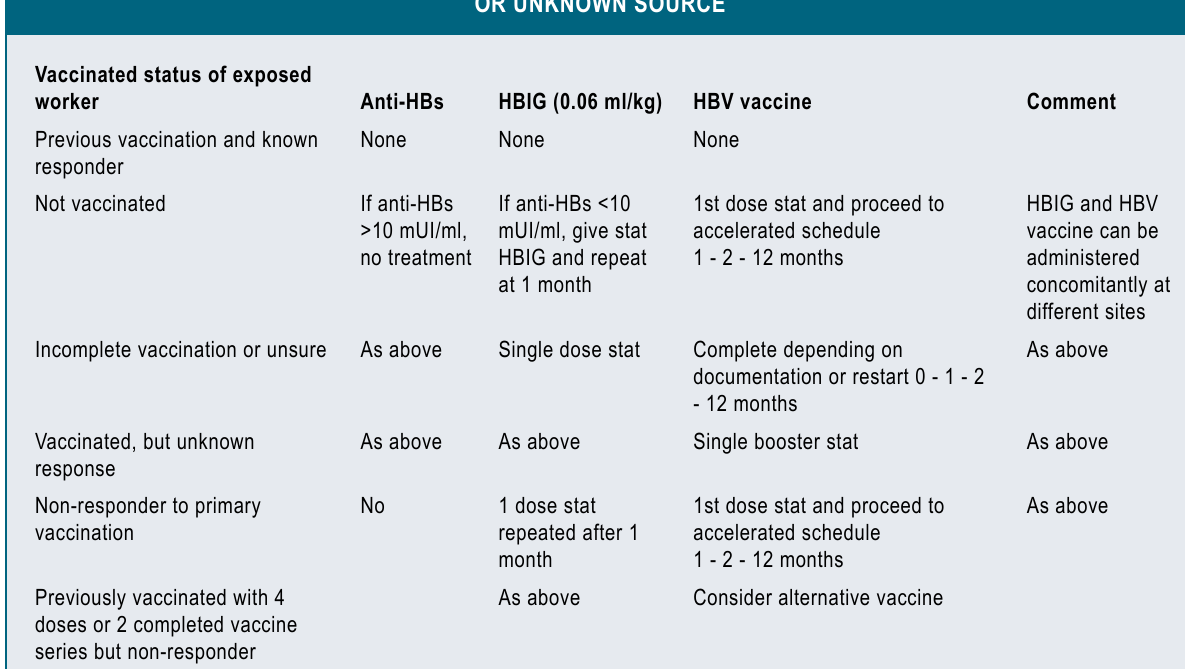
TABLE II. MANAGEMENT OF HEALTH CARE WORKER EXPOSED TO HBsAg-POSITIVE OR UNKNOWN